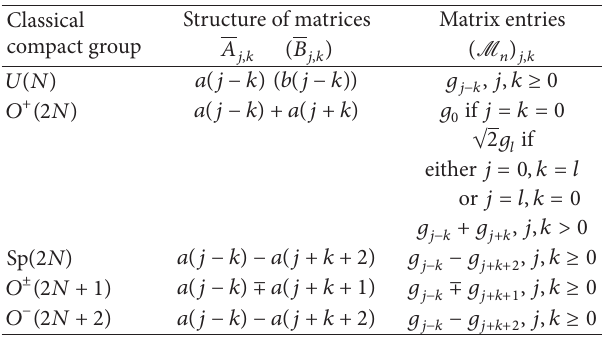
Table1:Thestructureoffunctions 𝑎(𝑗) and 𝑏(𝑗) dictatingtheentries of matrices A = A − 2ℎ I and B = 𝛾 B , which reflect the respective symmetry groups. The 𝑔 𝑙 s are the Fourier coefficients of the symbol 𝑔 M (𝜃) of M 𝑀 . Note that, for all symmetry classes other than 𝛾 = 0 and thus B = 0